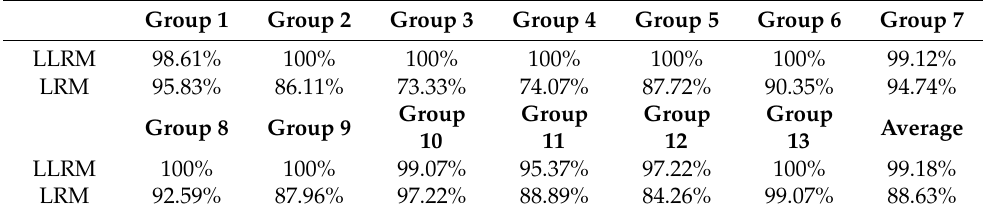
Table 6. Comparison of recognition accuracy between LLRM and LRM using FD data.